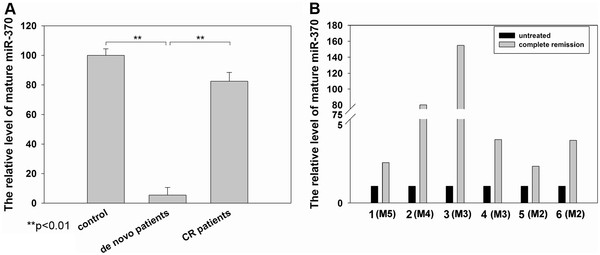
Downexpression of miR-370 in de novo AML patients. (A) miR-370 expression by qRT-PCR in 48 de novo AML patients, 40 AML patients of 1st CR and 21 healthy controls. (B) Restoration of miR-370 expression in six patients after complete remission achievement in induction chemotherapy. The results are shown as miRNA expression after normalization with U6 and -ΔCt calculations